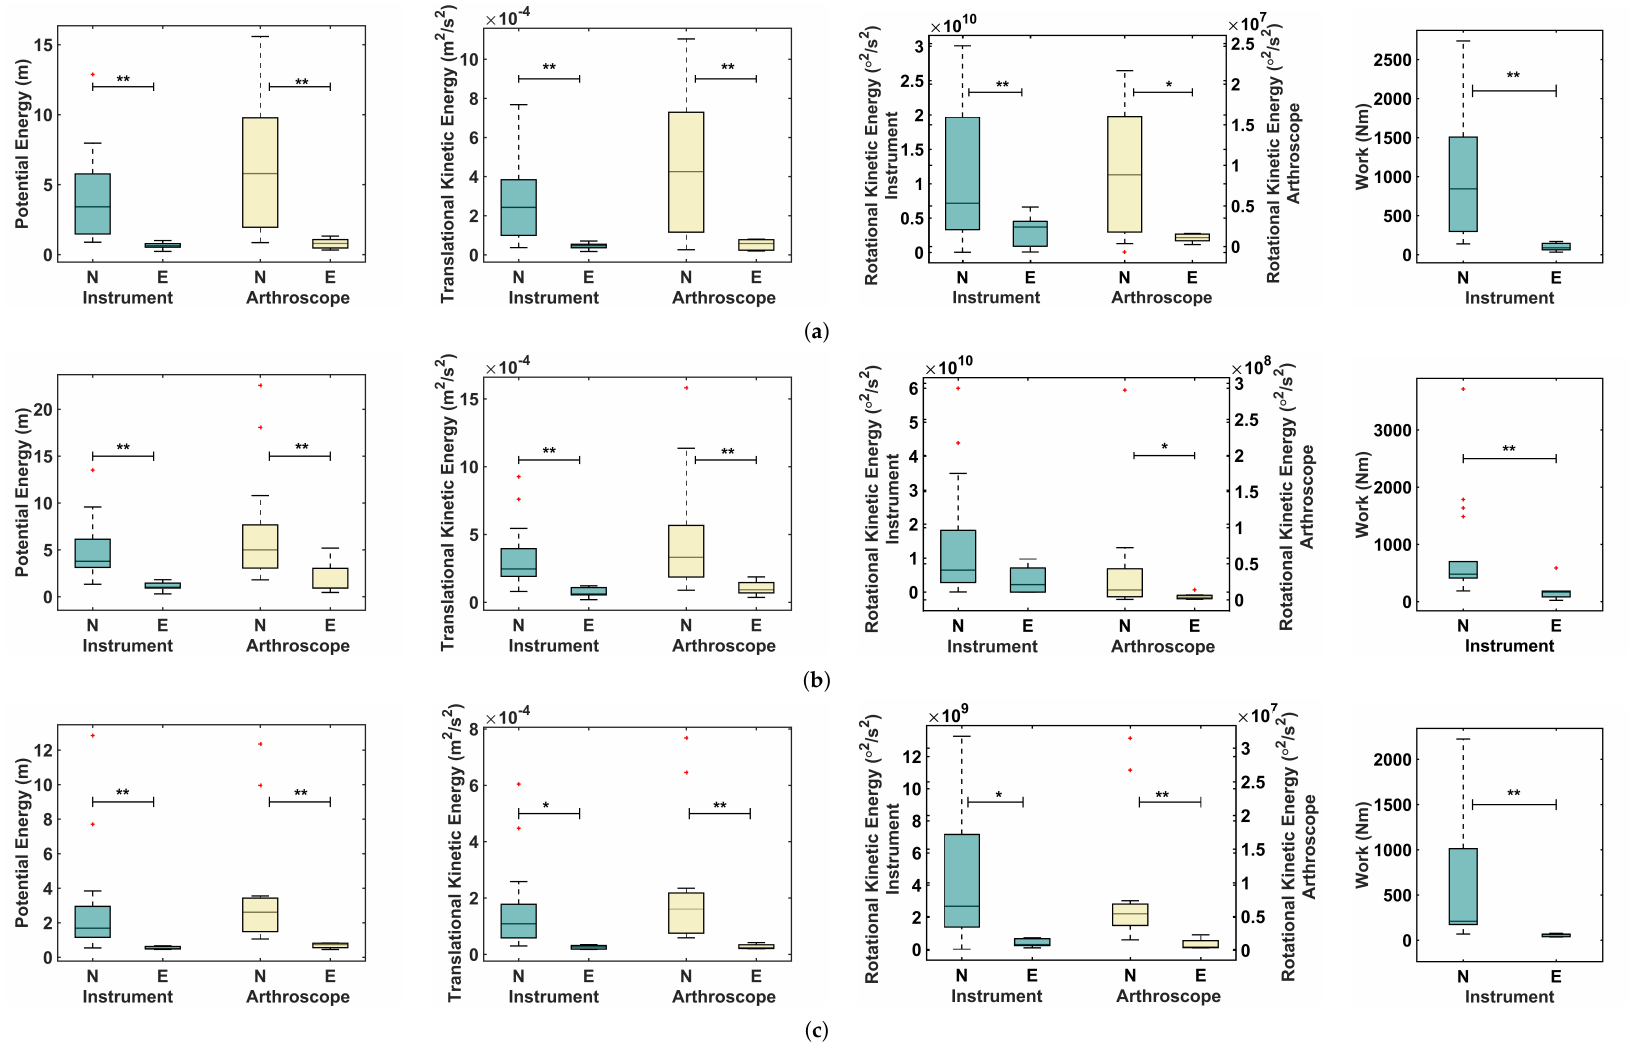
Figure 4. Energy-based metrics for the instrument (left) and arthroscope (right). ( a ) Task 1, ( b ) Task 2, and ( c ) Task 3. In this figure, ** indicates a statistically significant difference with p value less than 0.01 and * indicates a statistically significant difference with p value less than